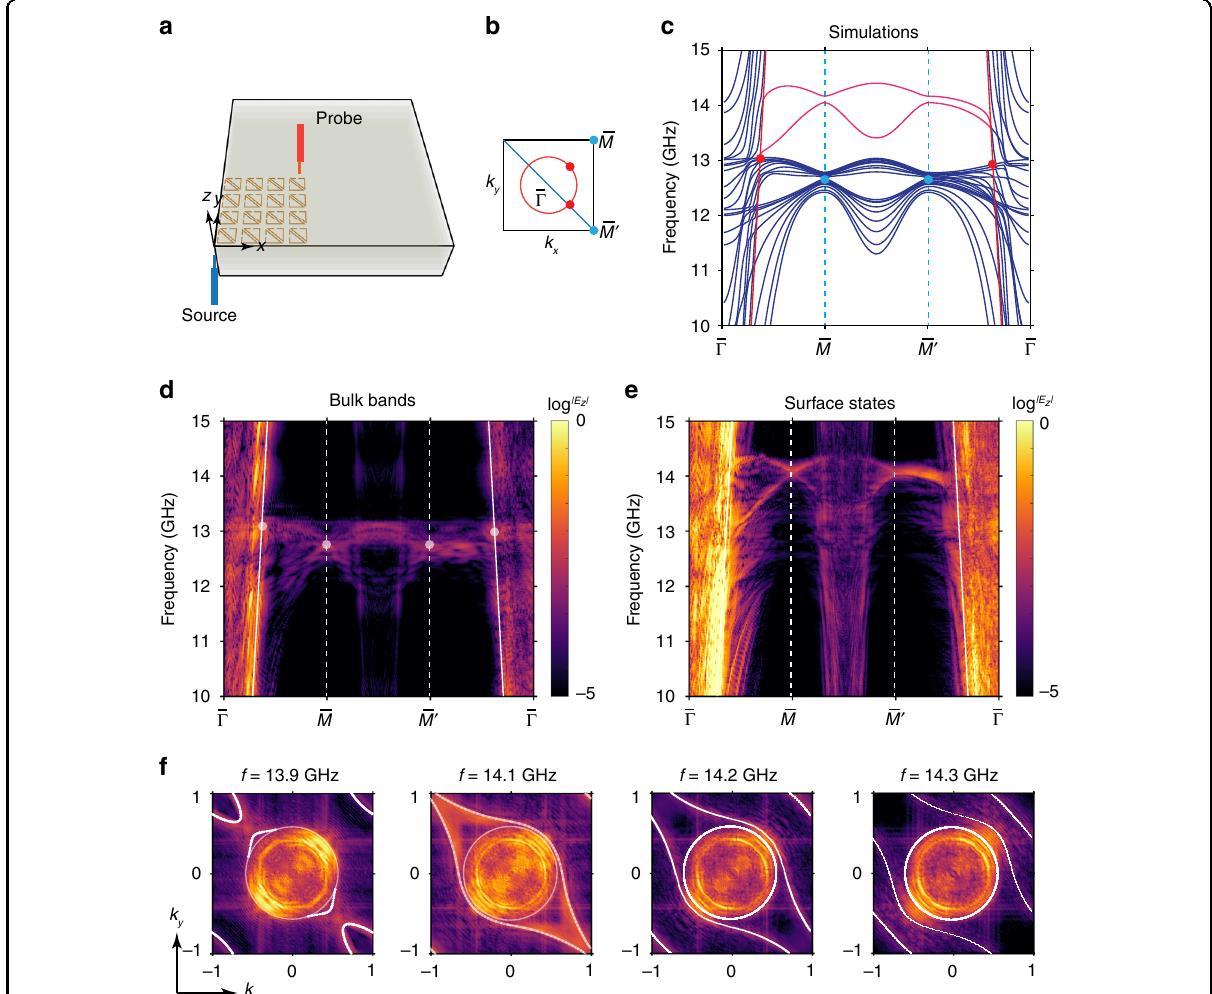
Fig. 5 Experimental measurements of nodal lines and surface modes at the top surface. a Schematic of the experimental measurement con fi guration on the top surface (xy plane). The source and probe antennas are colored in blue and red, respectively. b Surface Brillouin zone of the top surface. Blue line indicates the projection of in-plane nodal chain and red circle is the nodal ring projection. c Calculated projected band spectra for the top surface. Surface modes are indicated with red color. Blue (Red) dots indicate the degenerate points on the in-plane nodal chain (nodal ring), as also illustrated in b. Substrate light cone is shown as red solid lines ( ε b ≈ 1.8). It should be noted that the slight difference of effective permittivity from above measurement is due to the sample compactness in two con fi gurations. d , e Measured bulk bands and surface states on the top surface, respectively. Degeneracy positions of nodal chain (ring) are indicated with white dots in d . Substrate light cones are shown as white solid lines. f Measured and calculated (white lines) EFCs of surface states at the frequencies of f = [13.9, 14.1, 14.2, 14.3] GHz. EFCs for substrate light cone are shown as white